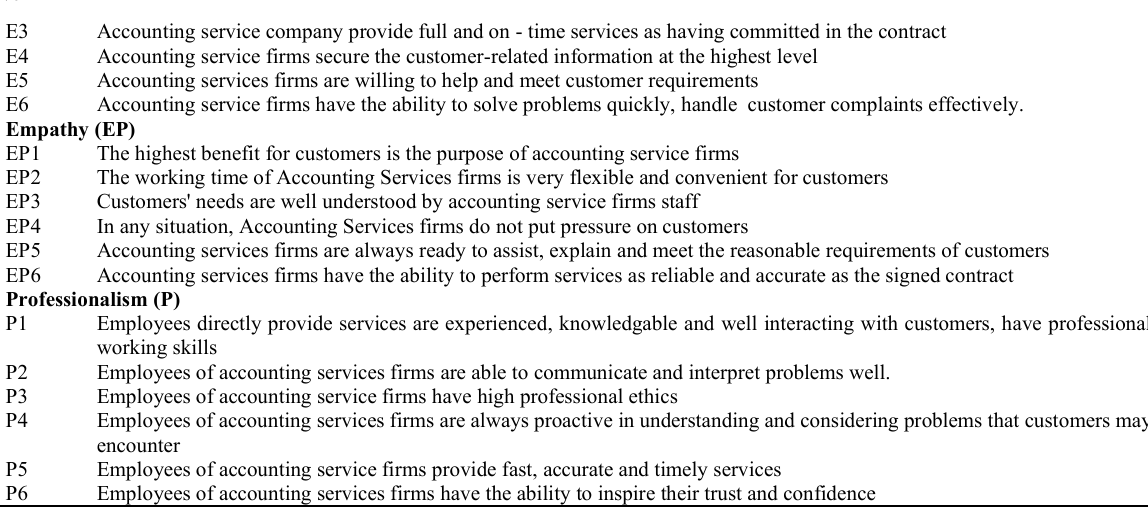
Respondents by gender